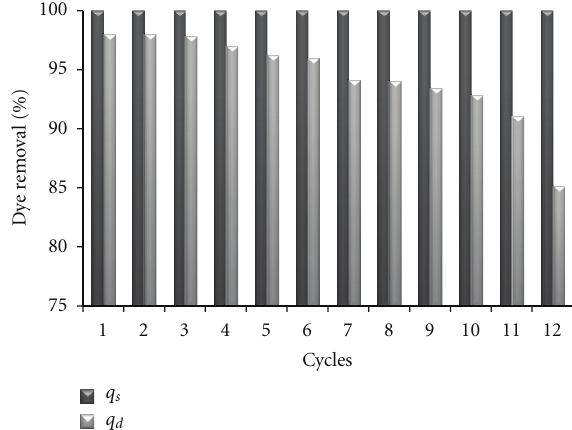
F 10: Quantity of dye accumulated in dye sorption desorption cycle. T 3: ermodynamic parameters of adsorption of AO-7 on ANP.